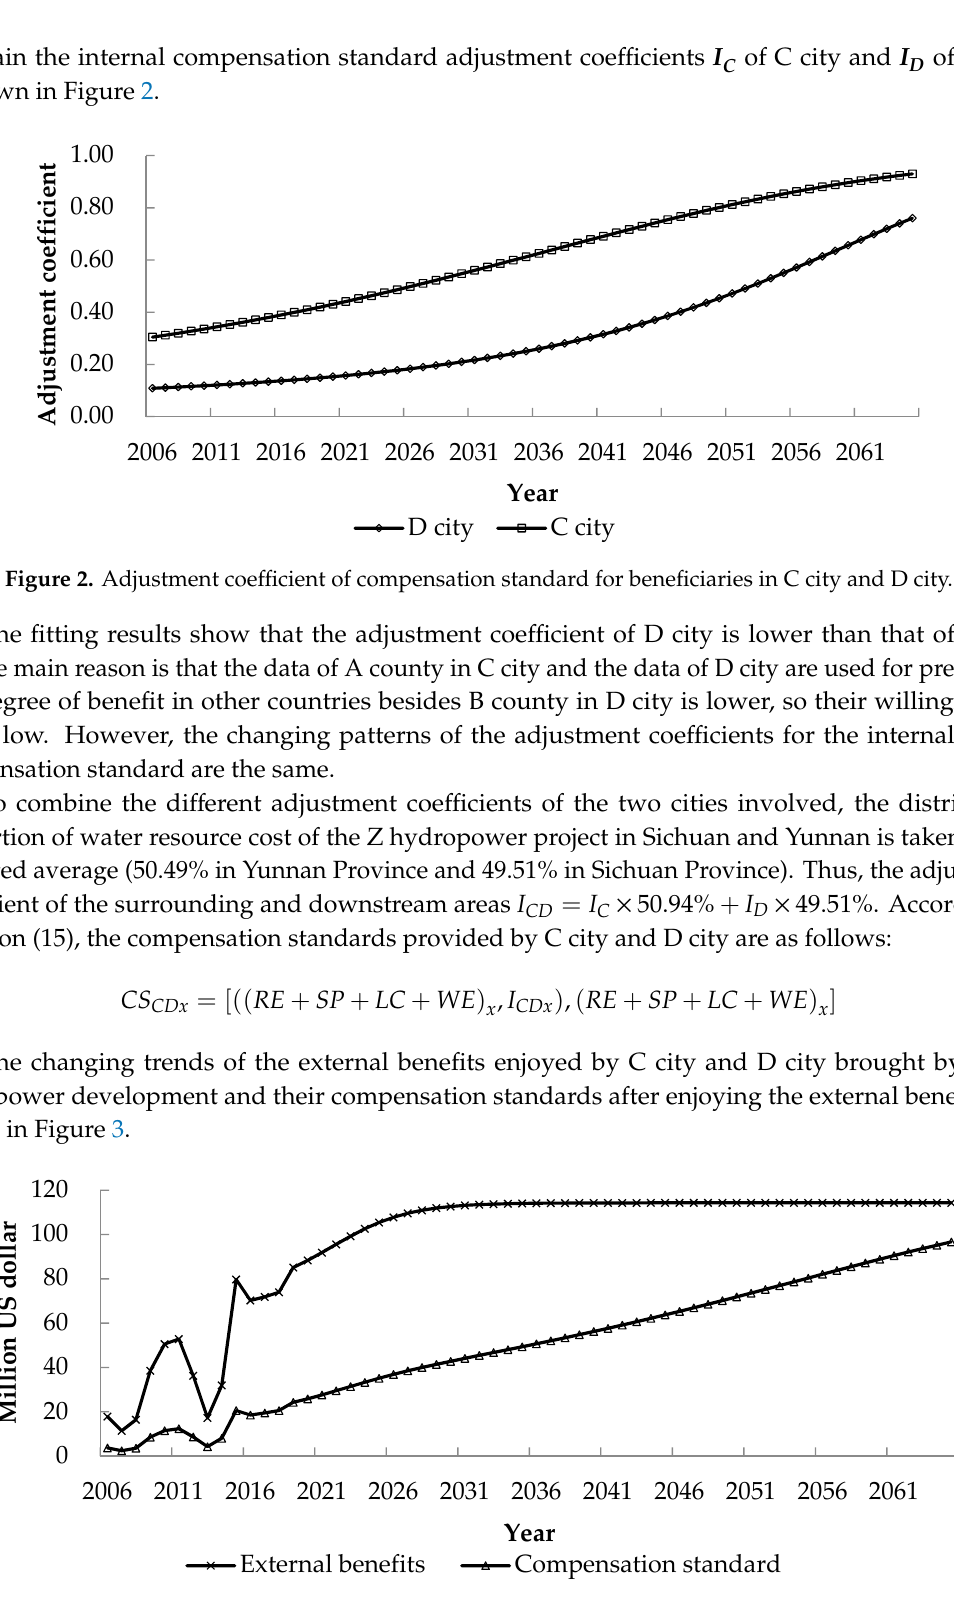
Figure 3. External benefits enjoyed and compensation standards provided by beneficiaries in C and D cities.